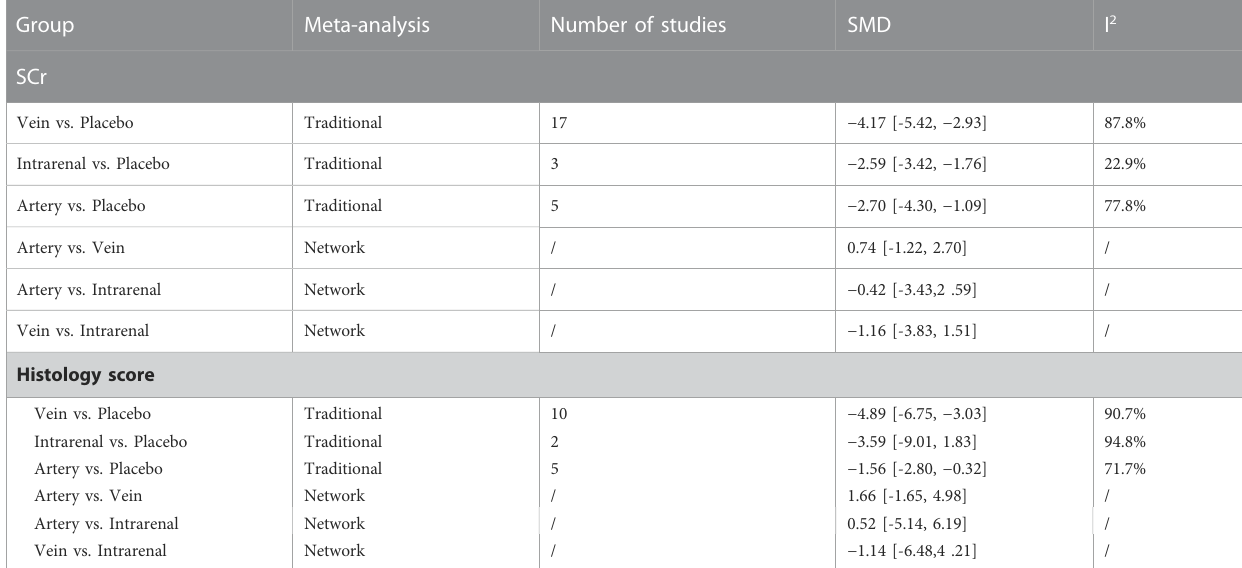
TABLE 2 Comparison of different transplantation routes in low dose groups. Group Meta-analysis Number of